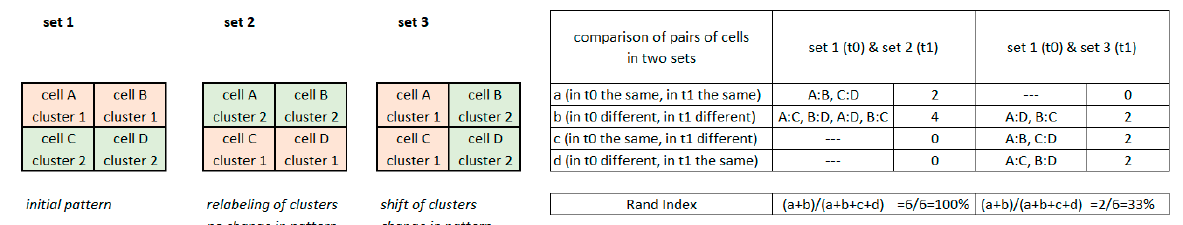
Figure A1. Example analysis of patterns with the Rand Index.